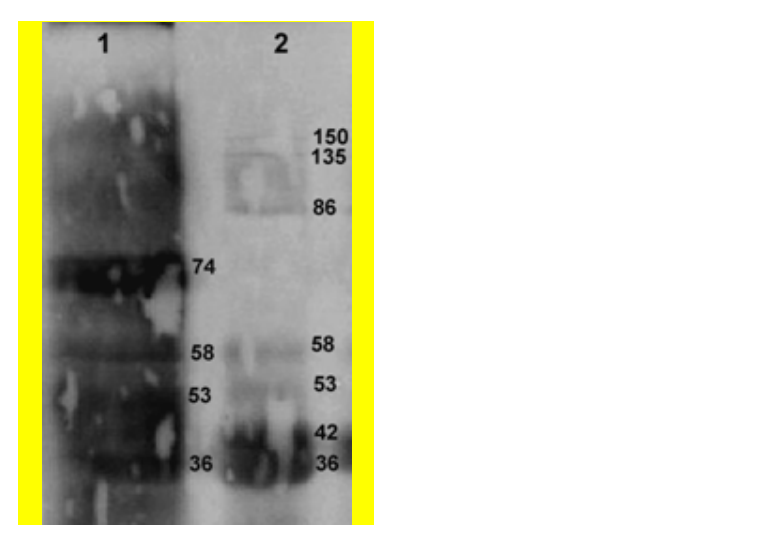
Figure 4. Western blotting using Androctonus crassicauda venom (1:1000). Lane 1: venom obtained by maceration of telsons; Lane 2: venom obtained by electric stimulation. Venom samples were separated and transferred to nitrocellulose membranes. Bands were detected using antivenom. Table 1. Median lethal dose (LD ) of Androctonus crassicauda venom obtained by 50 two different methods (maceration and electric stimulation) and subcutaneously injected into mice. Similar symptoms were observed in mice during LD 50